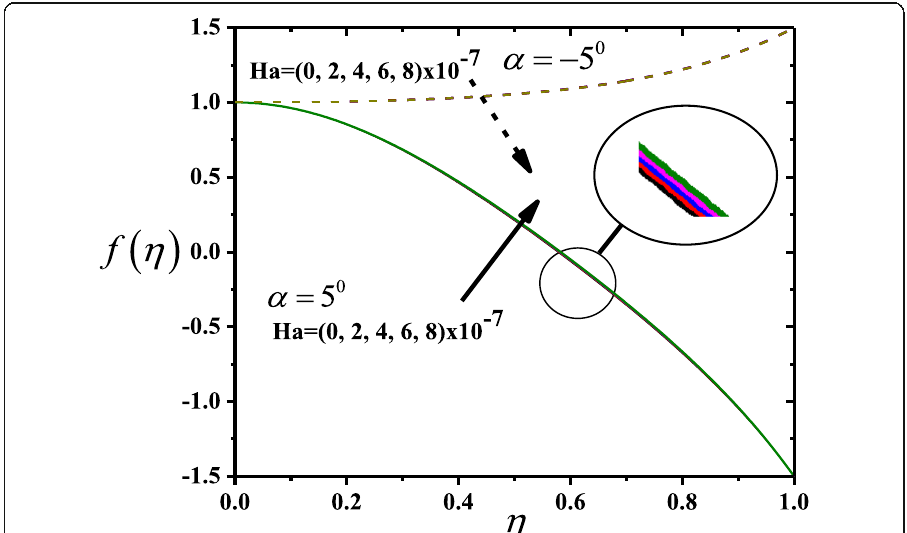
Fig. 3 Velocity vs. Ha in shrinking divergent and stretching convergent